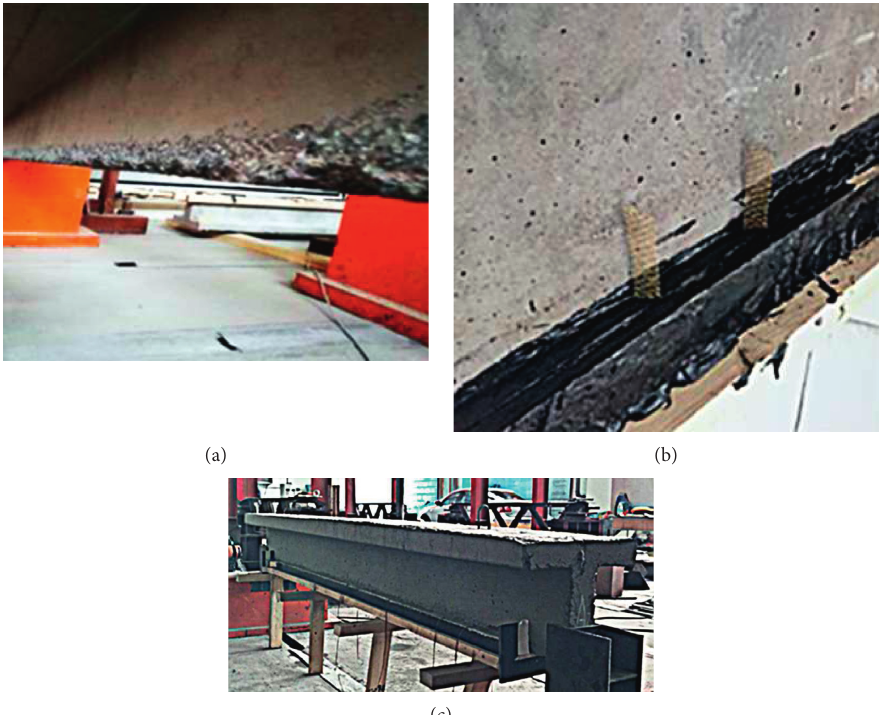
Figure 4: CPUC reinforcement process. (a) Chiseled treated beam bottom. (b) Imbedded electrode. (c) Support mold pouring.